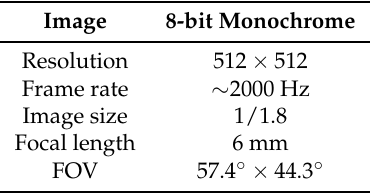
Table 2. Specifications of camera and lens.